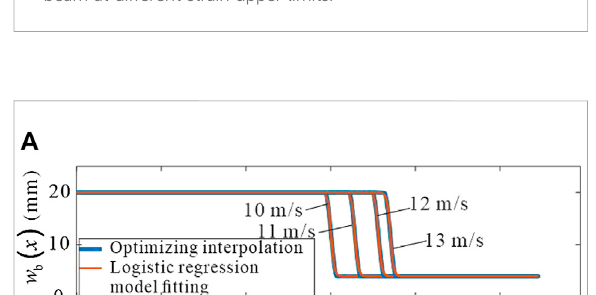
FIGURE 10 (A) Optimized beam at different wind speeds. (B) Optimized beam at different strain upper limits.